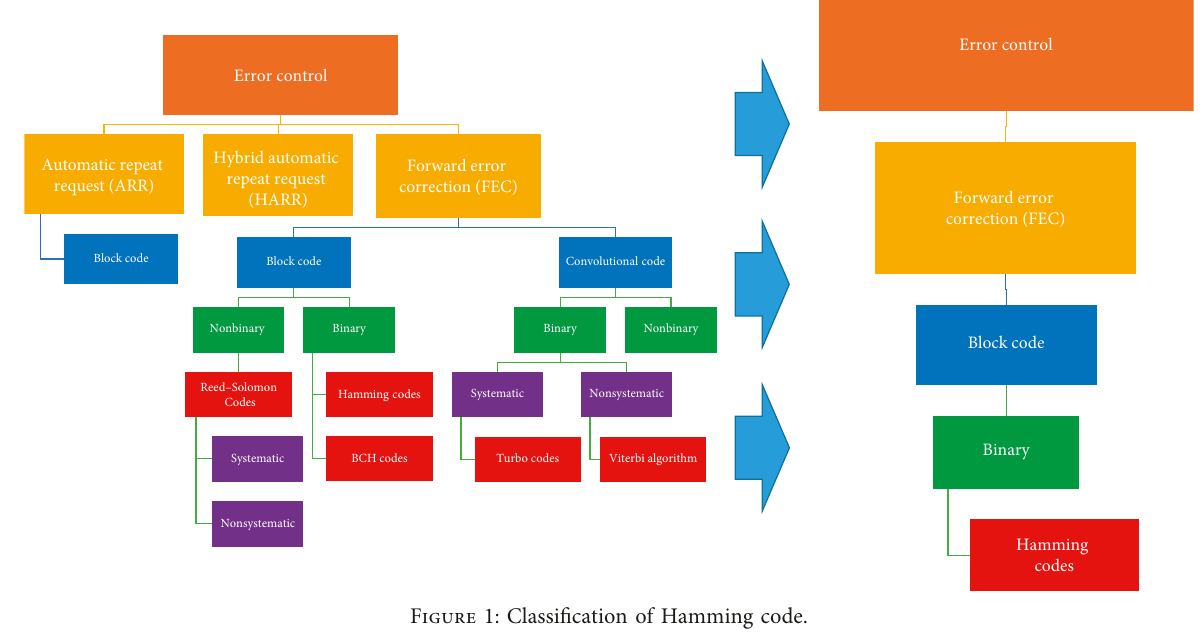
Figure 1: Classification of Hamming code.